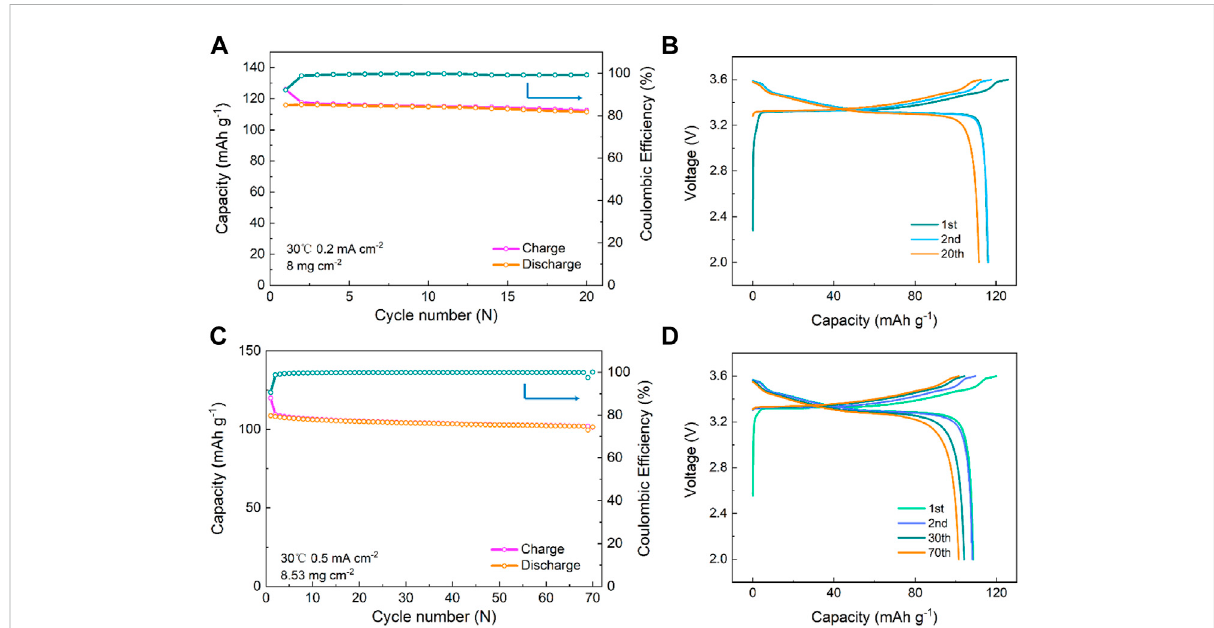
FIGURE 6 CyclingperformanceoftheIn/InLi|LPSB|LCO(coated)-LPSBASSBsatdifferentcurrentdensitiesof (A) 0.2 mA cm − 2 and (C) 0.5 mA cm − 2 at30 ° C and (B and D) the corresponding discharge – charge voltage pro fi les of the cells at different cycles.